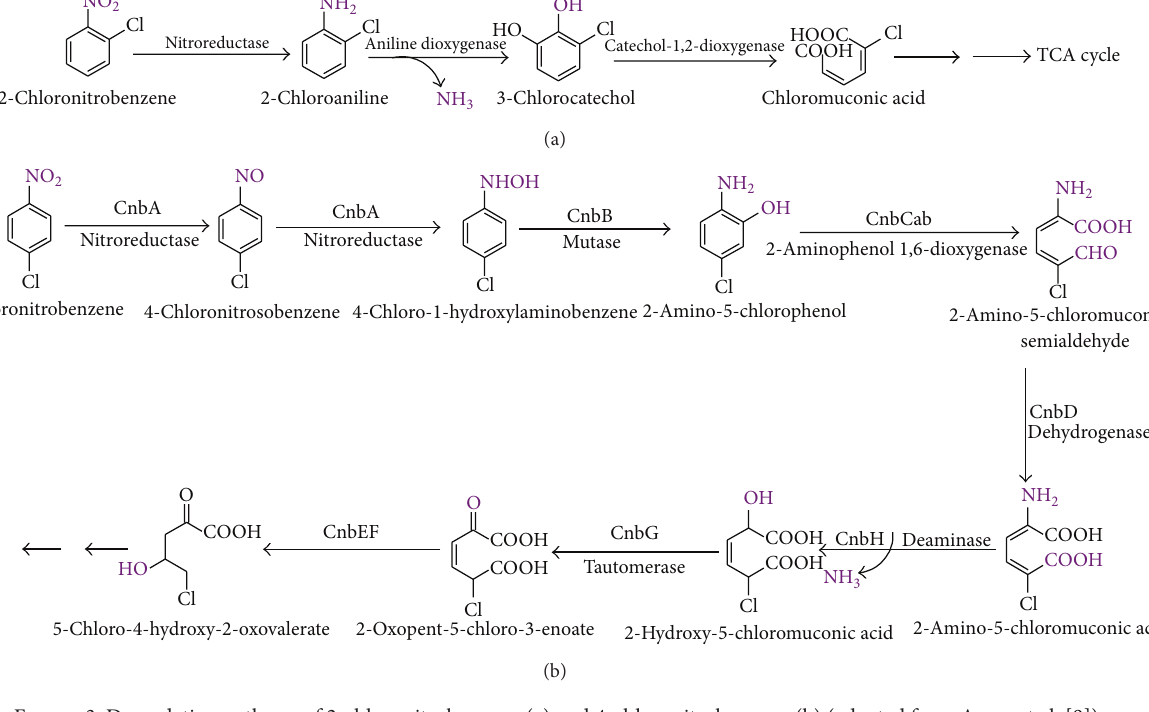
Figure 3: Degradation pathway of 2-chloronitrobenzene (a) and 4-chloronitrobenzene (b) (adapted from Arora et al. [9]).